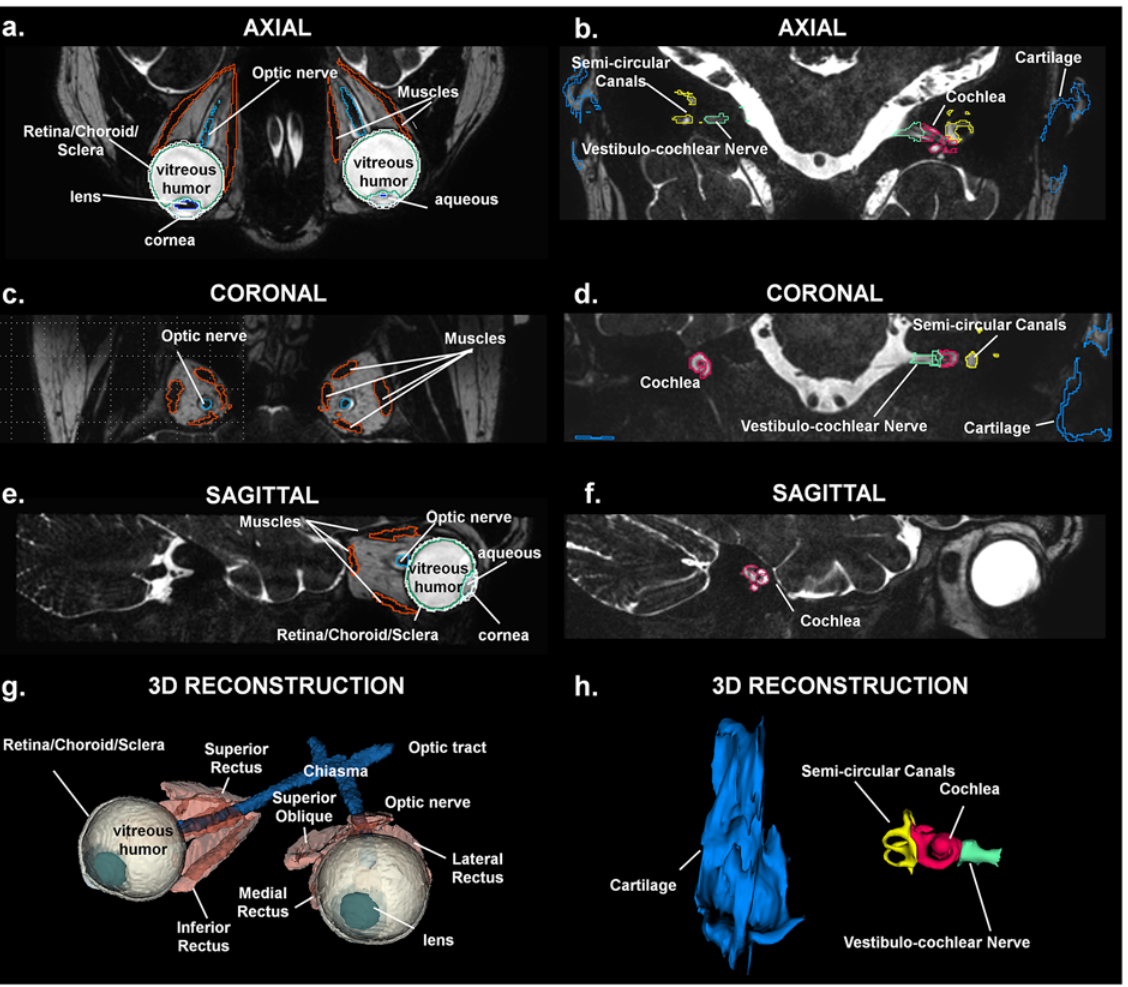
Fig 16. Segmentation of the eye and ear. T2 weighted axial, coronal and sagittal slab for the eye (left) and ear (right). The improved contrast allows for delineation of several thin substructures of the eye — e.g., optic nerve and lens — and ear — e.g., cochlea, semi-circular canals, and vestibulocochlear nerve — and the surrounding fat and fluids. 3D reconstruction (bottom) of the eye (left) and the ear (right) substructures.